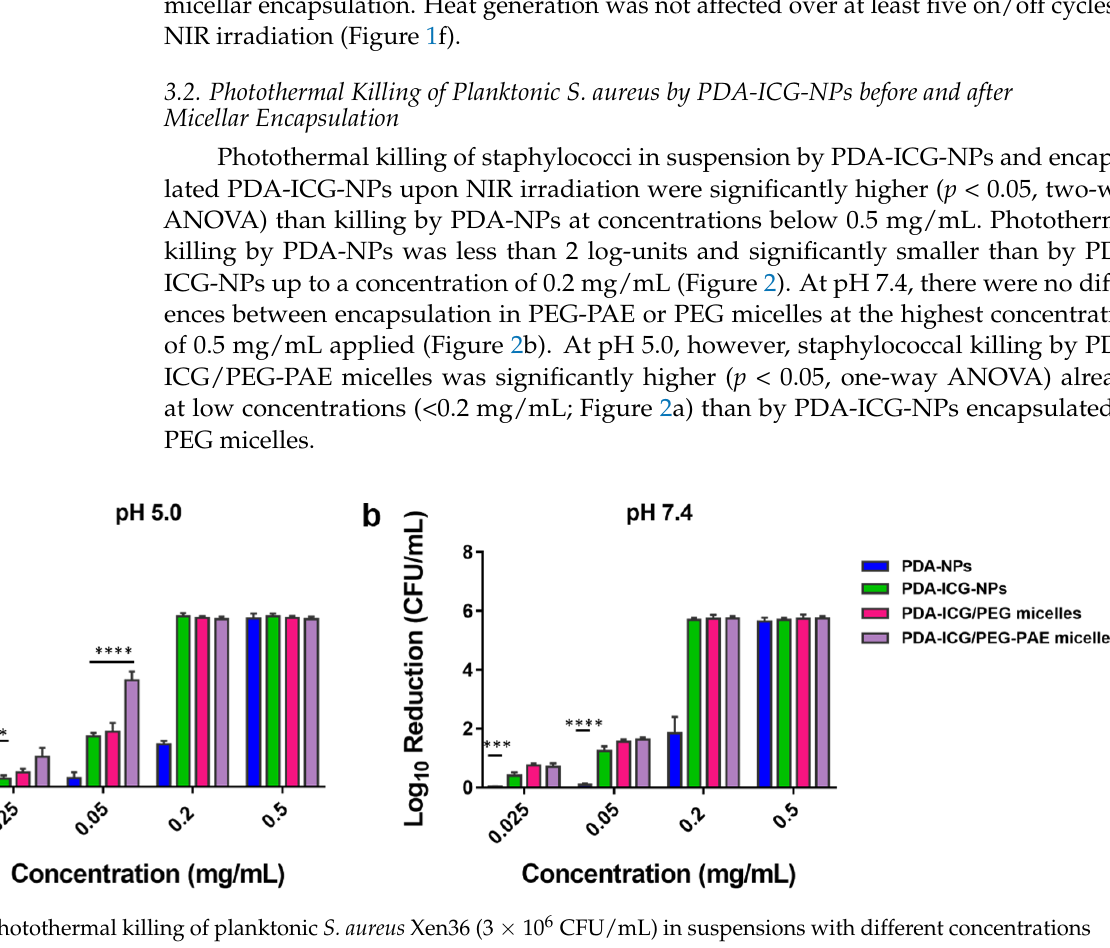
capsulation in PEG-PAE or PEG micelles, obtained using DLS in PBS. ( d ) Zeta potentials of nanoparticles in 10 mM phosphate buffer at different pH before and after encapsulation in PEG- and pH-responsive PEG-PAE-micelles. Data represent means ± standard deviation over triplicate experiments. ( e ) Temperature of nanoparticle suspensions with and without micellar encapsulation in PBS (250 µ L, 0.2 mg/mL) as a function of NIR irradiation time (808 nm, 1300 mW/cm 2 ). ( f ) Photothermal stability of PDA-ICG/PEG-PAE micelles as a function of time during repetitive NIR irradiation. See panel e for conditions applied. ON/OFF refers to the action of turning the NIR-laser on or off.